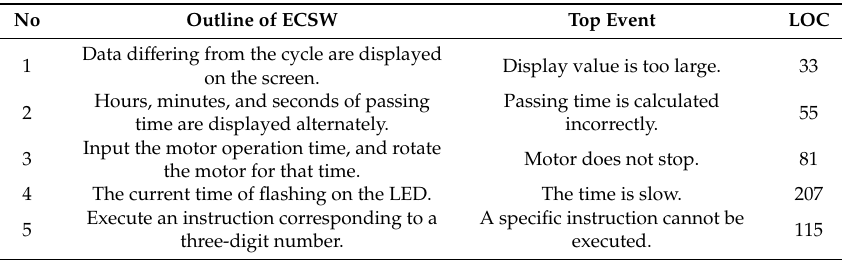
Table 2. Results of application of the proposed method.